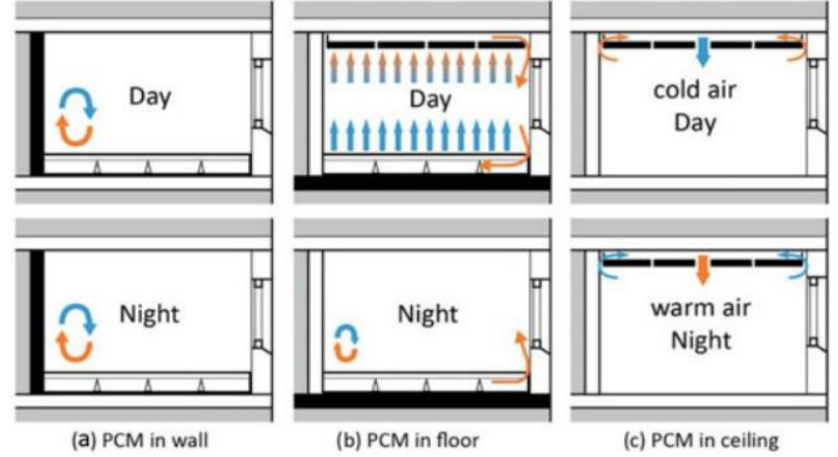
Figure 13. PCM is included into the construction of the building